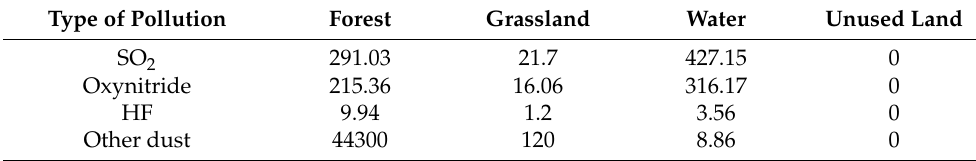
Table 1. Purification rate of air pollutants for each land use per unit area (kg/hm 2 • A − 1 ). Type of Pollution Forest Grassland